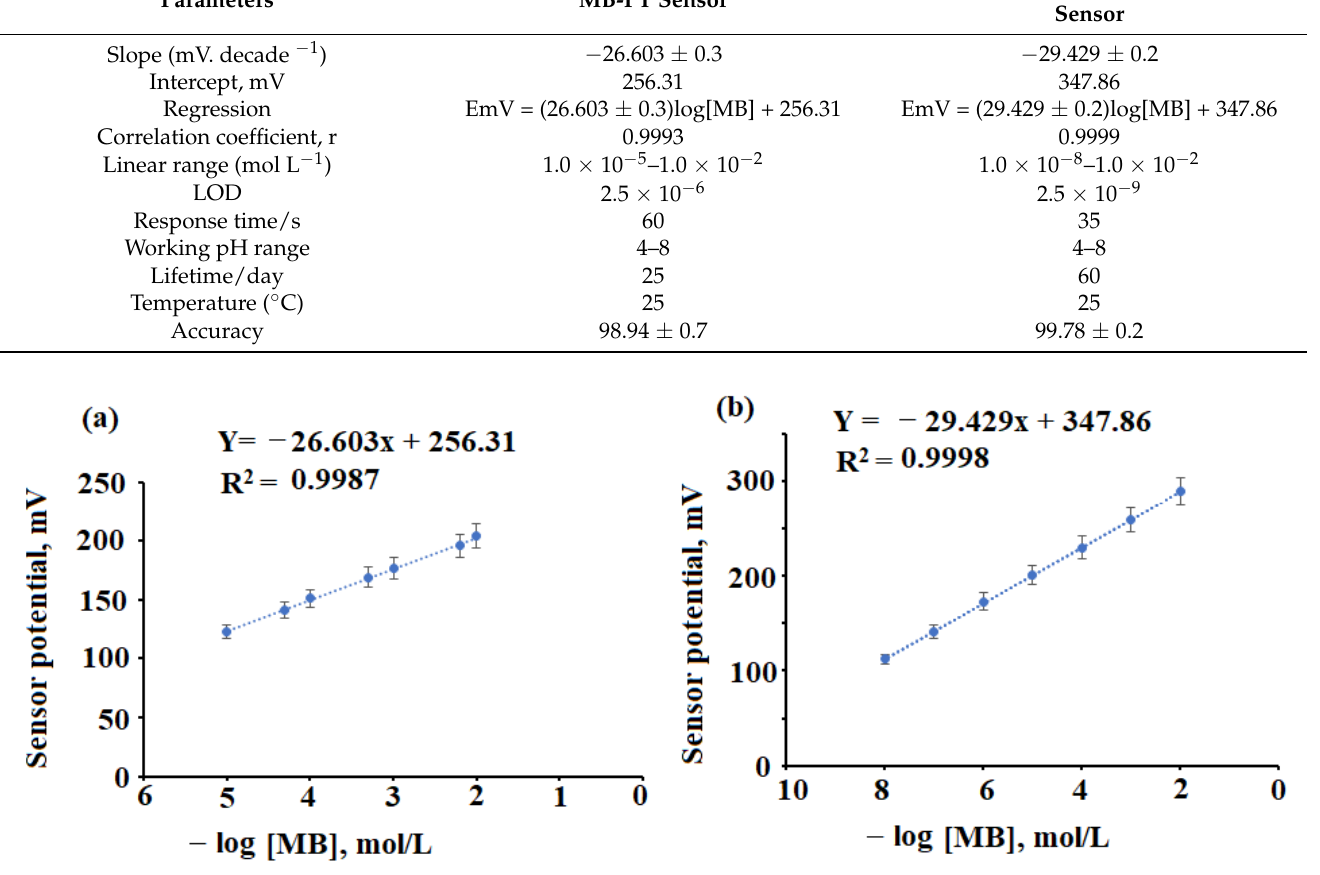
Figure 7. Calibration plots of ( a ) MB-PT sensor using 1.0 × 10 − 5 –1.0 × 10 − 2 , ( b ) functionalized MB-PT-